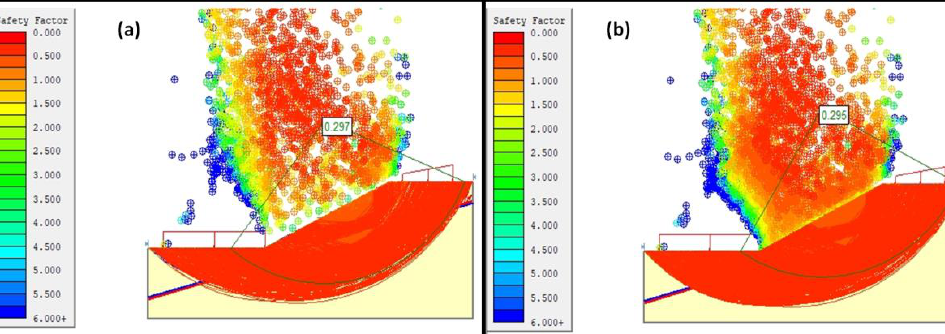
Figure 21. Safety factor simulated for rainy conditions in silt clay soil slope using ( a ) Corp of Engineers’ Number Two method and ( b ) Lower Karafiath method.